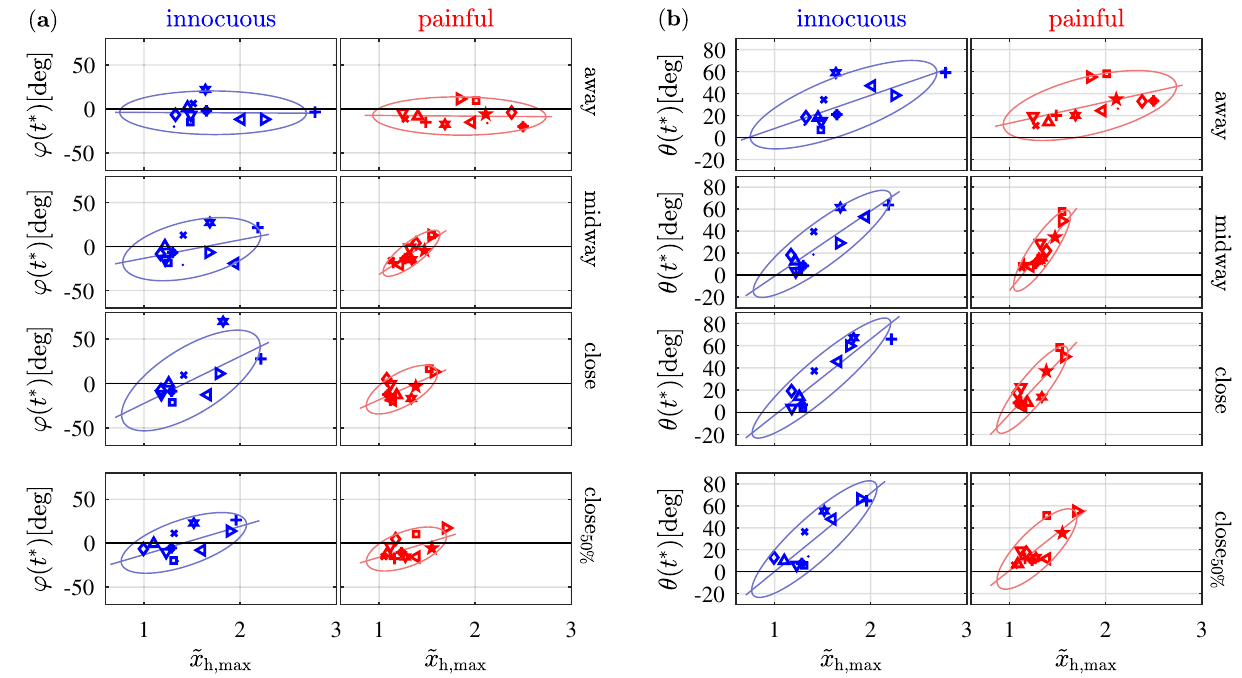
Figure 4. The figure shows values of sideways displacement ϕ( t ∗ ) of the elbow ( a ) and values of upward displacement θ( t ∗ ) of the elbow ( b ) at the point of maximum hand retraction ˜ x h,max (1). Each symbol represents the mean of such dyad for one individual subject. ϕ( t ∗ ) distributes evenly along the axis of hand retraction, and subjects seem to stick to one specific strategy (left, right or straight) over the different conditions, with only one exception (see blue triangle for innocuous). Ovals denote confidence ellipses with confidence interval 90%. Introducing a painful obstacle (red) reduces the area of the confidence ellipses. Solid lines denote the fitted linear models. Their slope increases as obstacles are introduced.